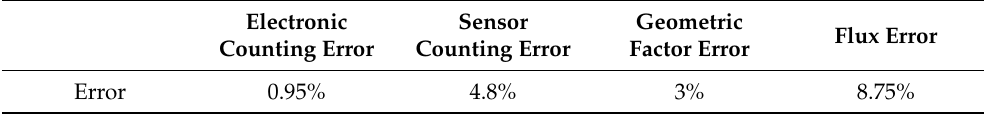
Table 6. Calibration results of particle